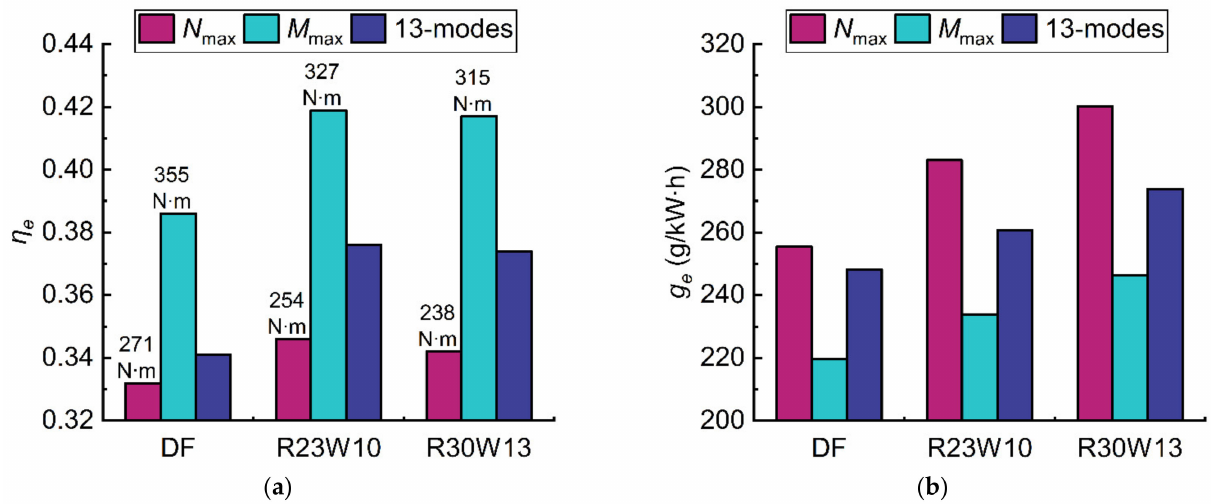
Figure 9. BTE η e ( a ) and BSFC g e ( b ) for DF and emulsified multicomponent biofuels in the maximum power ( N max ) and maximum torque ( M max ) modes and at the 13-mode test